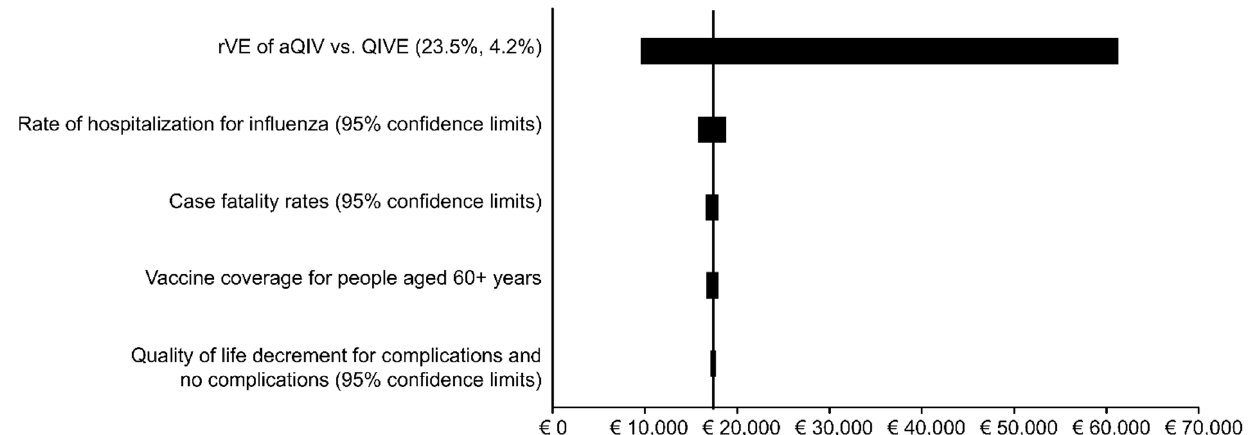
Figure 3. Tornado diagram: The impact of various deterministic sensitivity analyses on the estimated incremental cost-effectiveness ratio (SHI perspective).